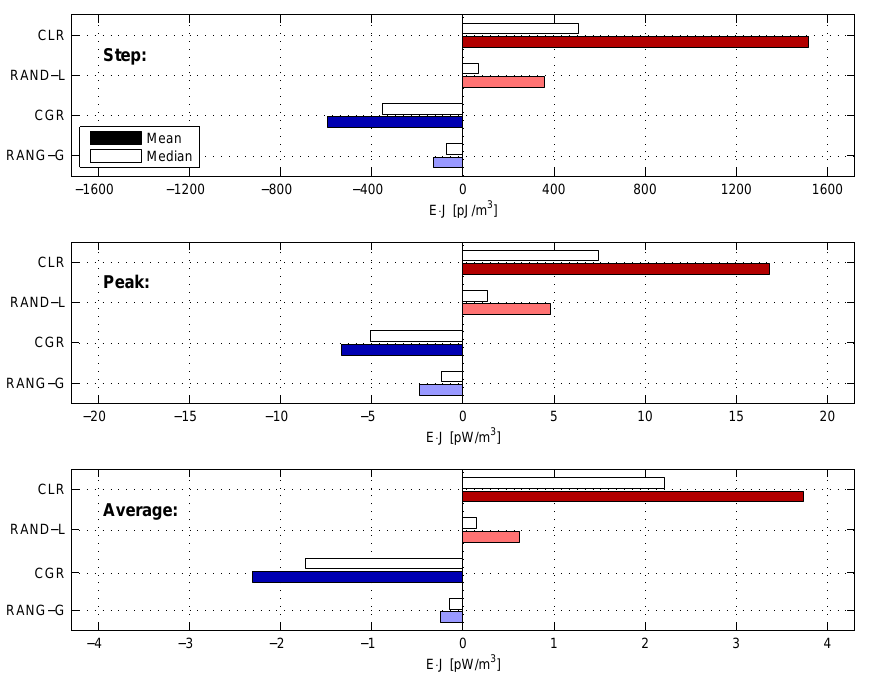
Fig. 5. Strength of the load and generator regions in the plasma sheet data from the summer and fall of 2001. The three panels show the step, peak and average strengths (cf. Fig. 1). Red and light red correspond to CLRs and RAND-Ls while blue and light blue correspond to CGRs and RAND-Gs. Note the different scalings of the x axes. On the average we see that the plasma sheet near 18 R E behaves as a load although it hosts both CLRs and